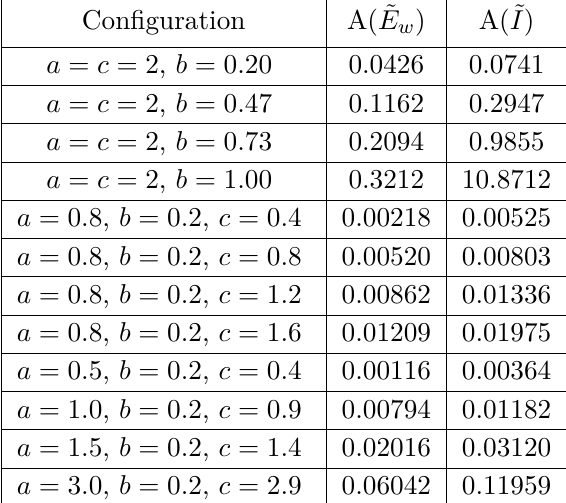
Table 1 . The growth rate A ( ˜ E w ) and A (˜ I ) at different